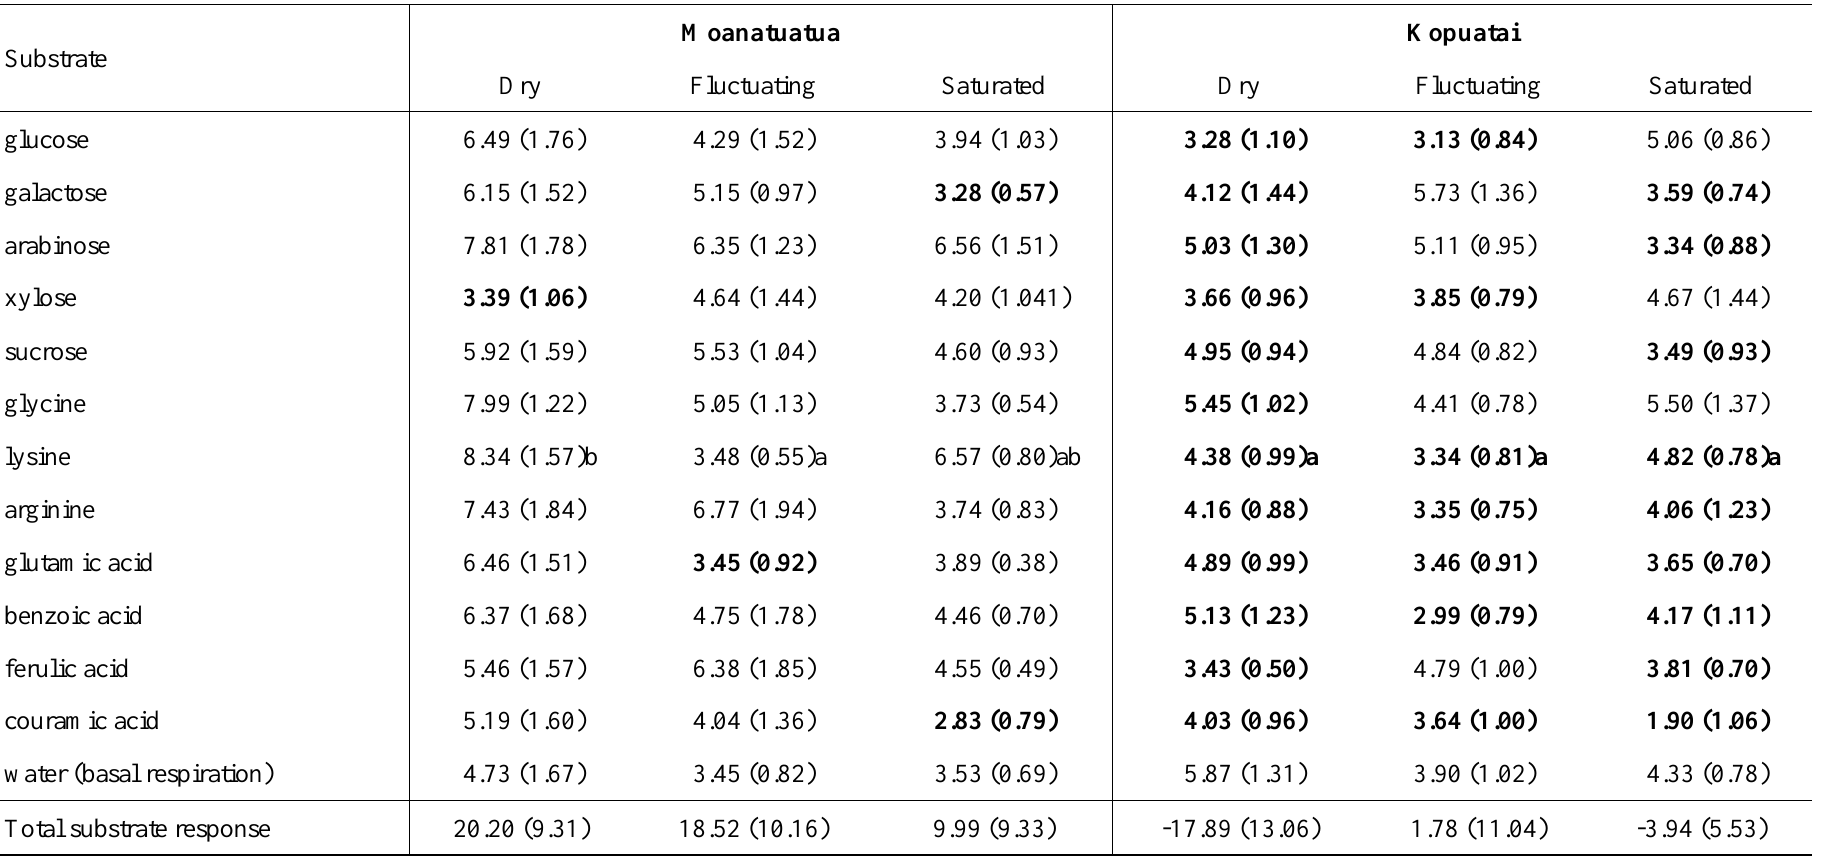
Table 5. Carbon dioxide (CO 2 -C) fluxes (mg g -1 ) after the addition of 12 carbon substrates and water, from peat in different hydrological zones at the Moanatuatua (degraded) and Kopuatai (intact) peatlands. Values in brackets represent the standard error of the mean ( n = 8). The only statistically significant differences between hydrological layers observed for the two sites were for lysine; values with different letters are significantly different ( P < 0.05). Values in bold were less than basal respiration (but differences were not statistically significant). Total substrate response is the sum of excess CO 2 -C flux over basal respiration across all substrates, and again this did not differ between hydrological layers at these